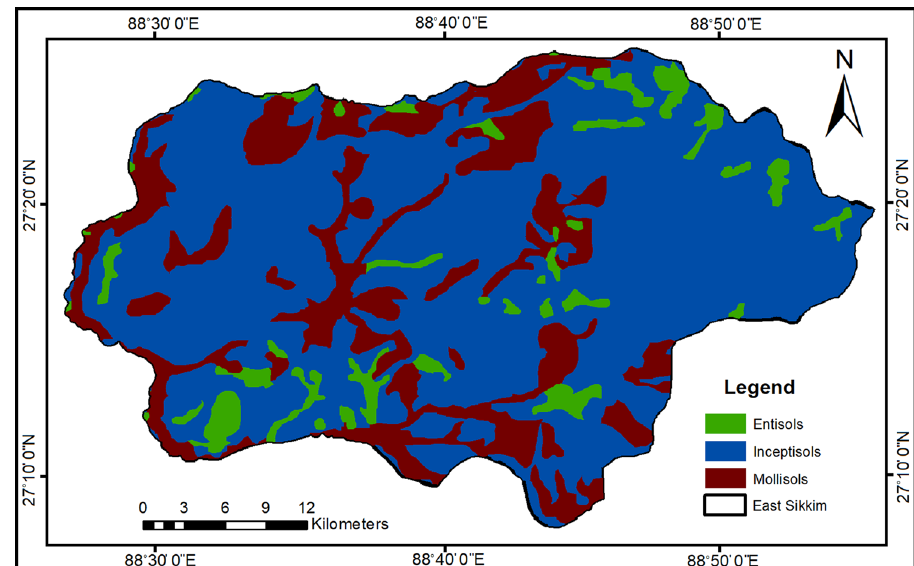
Fig. 4 Soil map of East Sikkim